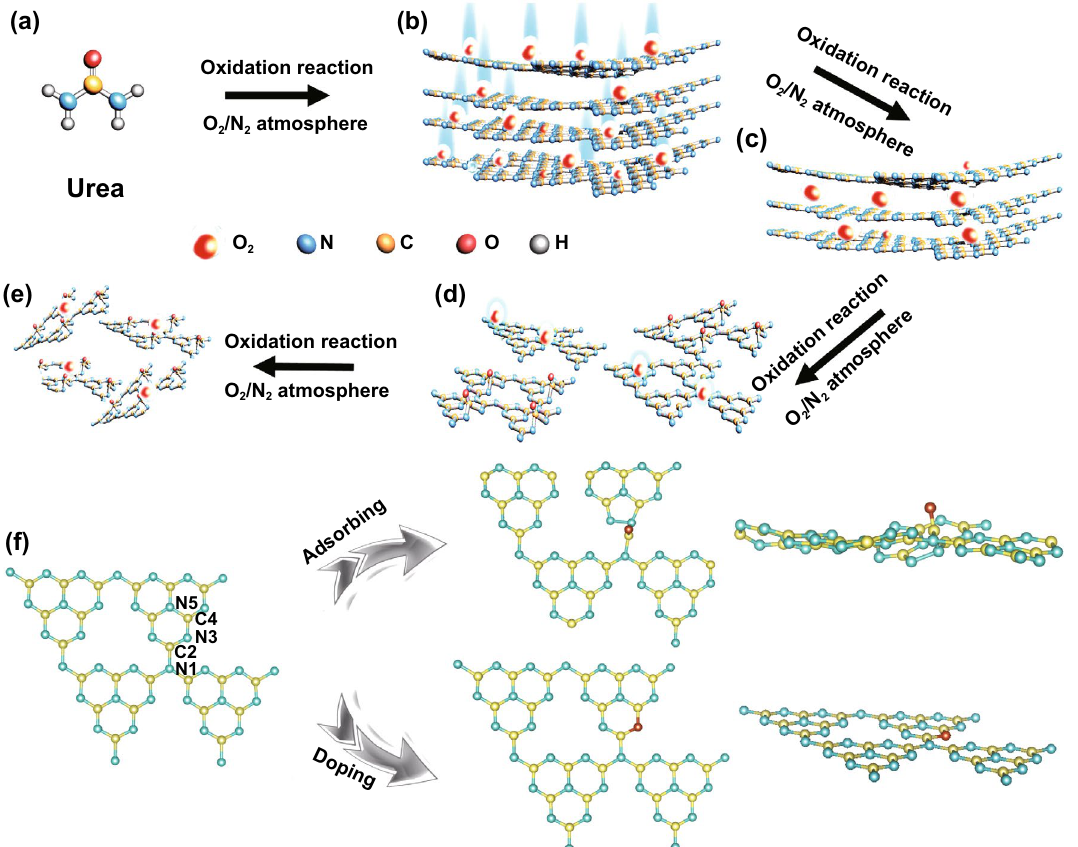
Fig. 1 a – e Synthetic route and f DFT computational simulation of OCN which oxygen atoms locate at C 2 (adsorbing site) and N 3 (doping site) with low